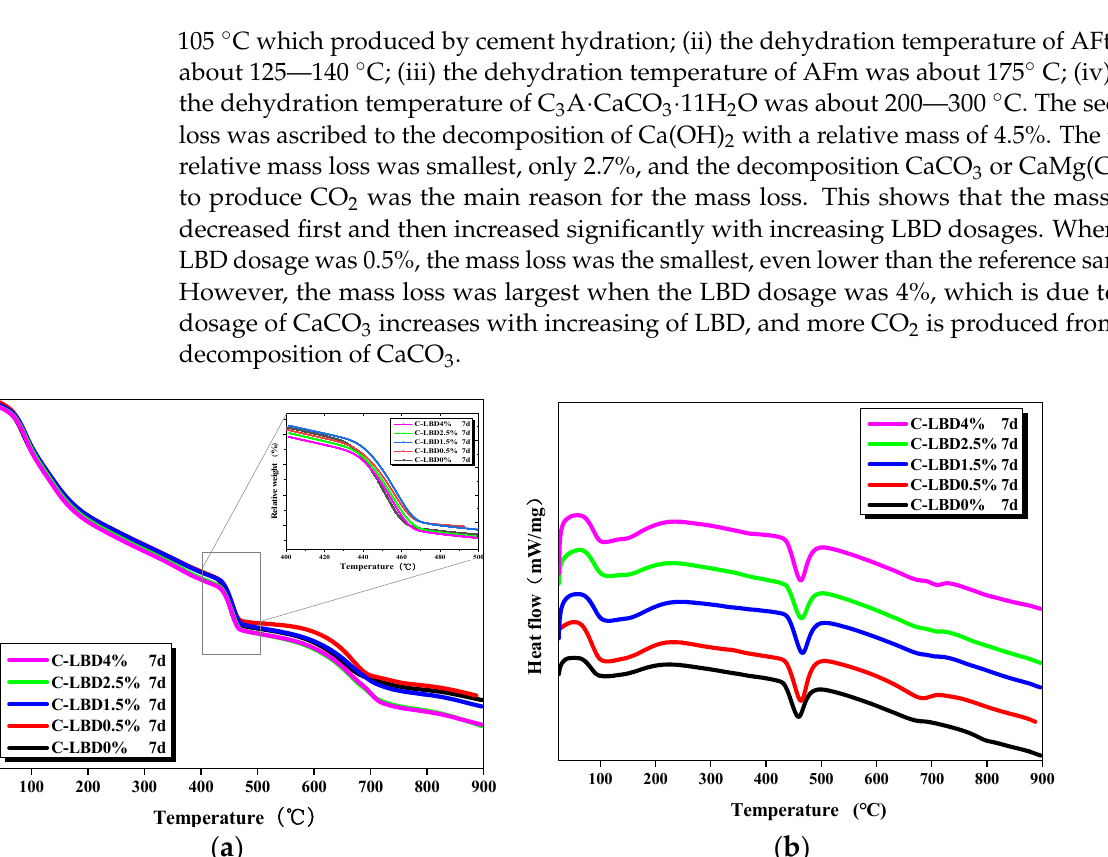
Table 3. Mass losses of the paste at different temperature ranges and corresponding processes Dosages of